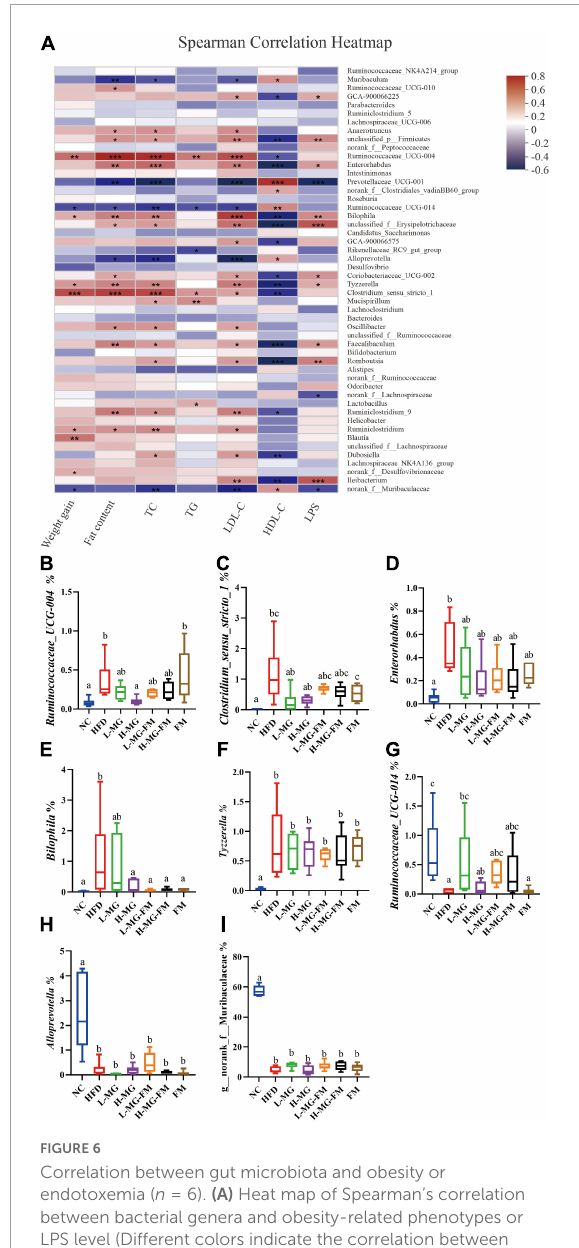
FIGURE6 Correlation between gut microbiota and obesity or endotoxemia ( n = 6). (A) Heat map of Spearman’s correlation between bacterial genera and obesity-related phenotypes or LPS level (Different colors indicate the correlation between bacterial genera and phenotypes, and red indicates positive correlation and blue indicates negative correlation. *0.01 < p ≤ 0.05, **0.001 < p ≤ 0.01, *** p ≤ 0.001). (B–I) The relative abundances of bacterial genera significantly correlated with obesity-related phenotypes or LPS